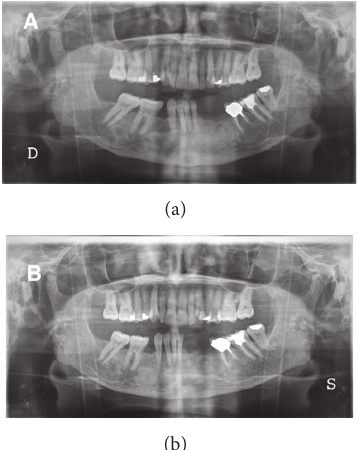
Figure7:Radiographicappearanceafterfourmonthsandtwoyears. (a) Signs of bone healing after four months after surgical excision of the parathyroid adenoma. (b) Complete recovery of the bony tissue two years after the